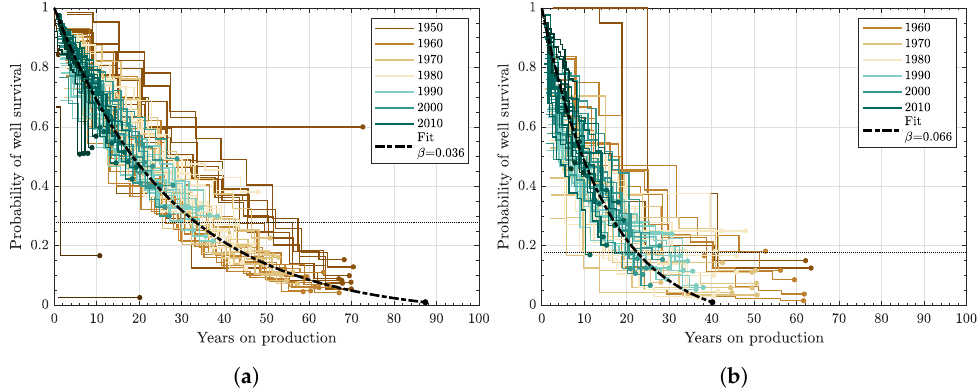
Figure 10. Survival probability plot for Permian region: ( a ) Central Basin—Leonardonian and ( b ) Midland Basin—Wolfcampian. The fitting function is y ( t ) = ( 1 + β )( e − t β − β ) .